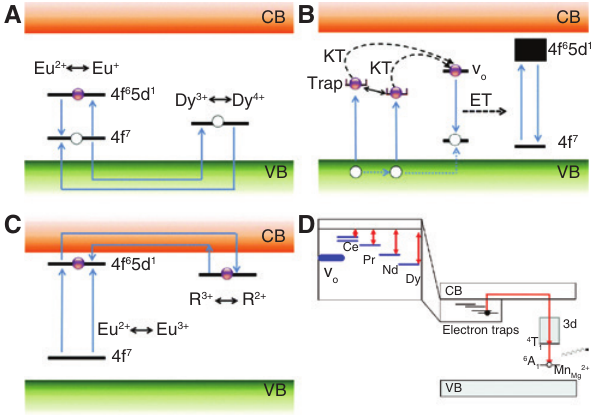
Figure 13: Proposed mechanism for some persistent luminescent